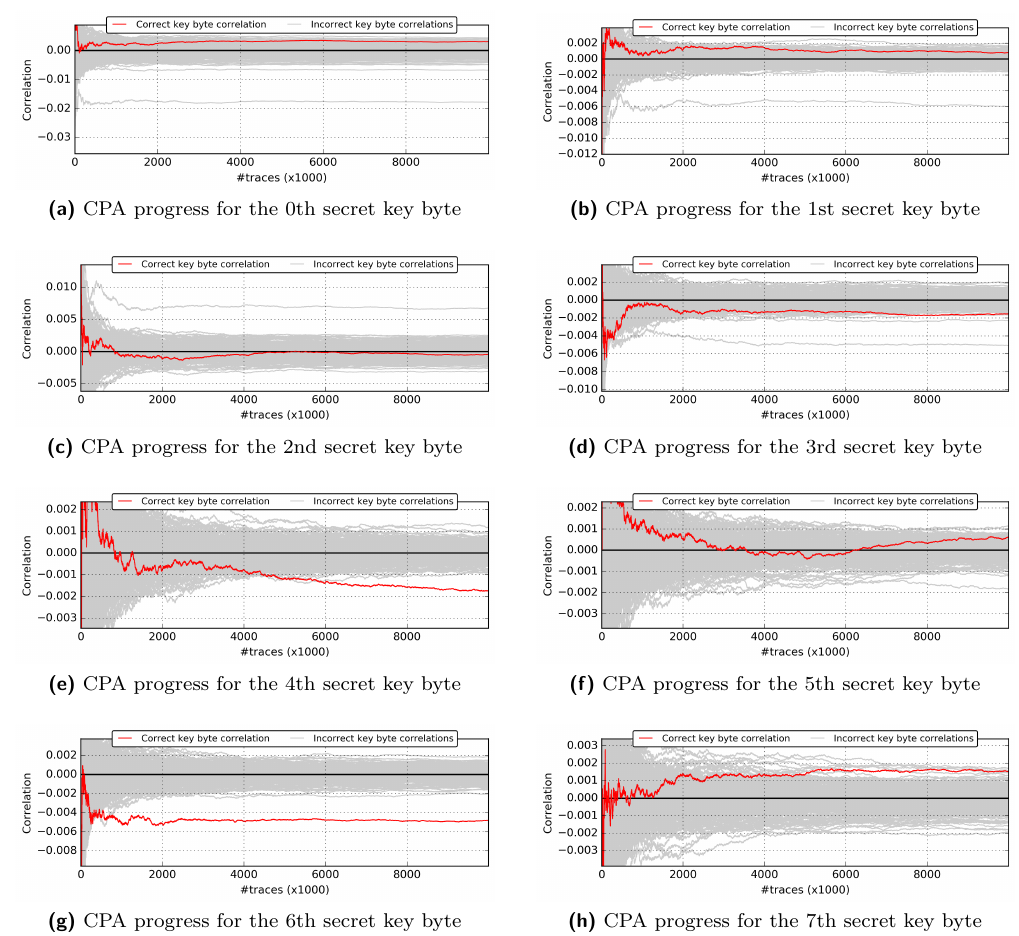
Figure 23: Results of a CPA attack on the last secret round key (bytes 0 to 7) of AES on the STM32F407VG Discovery #2 @56MHz with the ADC connected to Vdd and the program compiled with the -O0 optimization option. Each plot shows the correlation progress of all 256 key candidates for a specific key byte over 10 M traces and the respective correct key candidate is marked